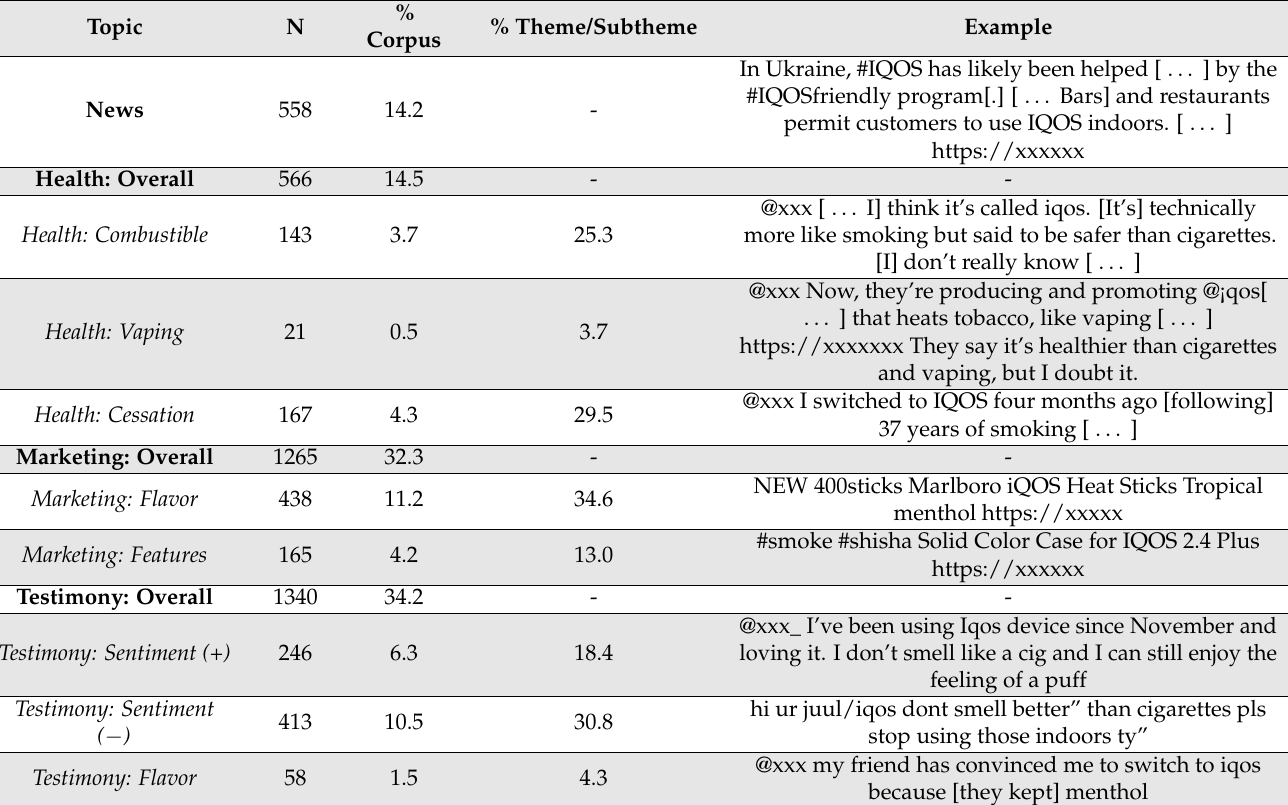
Table 1. IQOS tweet categorical descriptives and representative tweets (N =